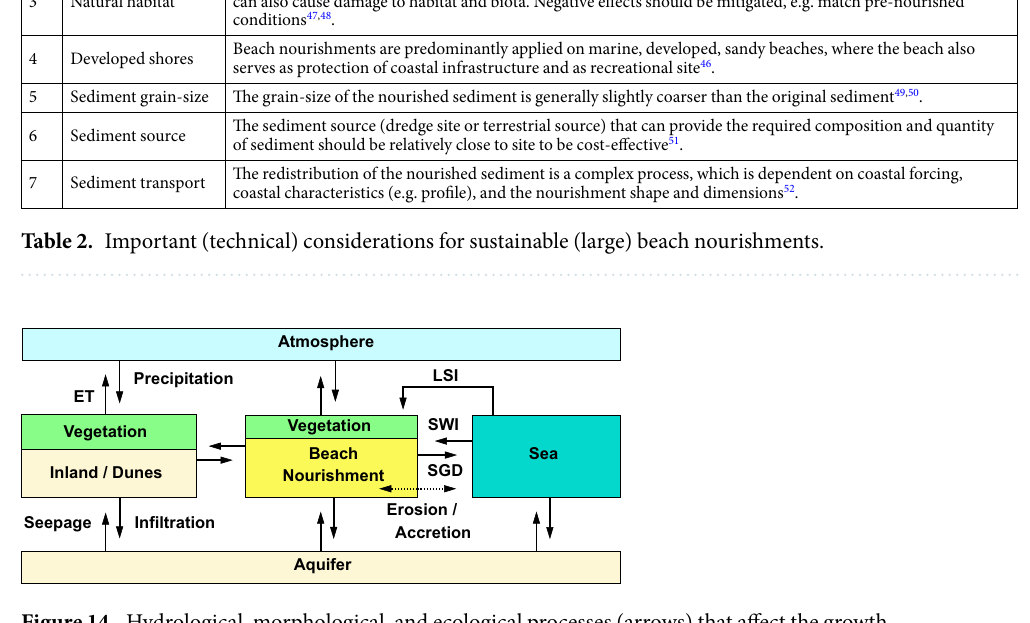
Figure 14. Hydrological, morphological, and ecological processes (arrows) that affect the growth of fresh groundwater resources in a (large) beach nourishment (LSI = land-surface inundations, ET = evapotranspiration, SGD = submarine groundwater discharge, and SWI = seawater